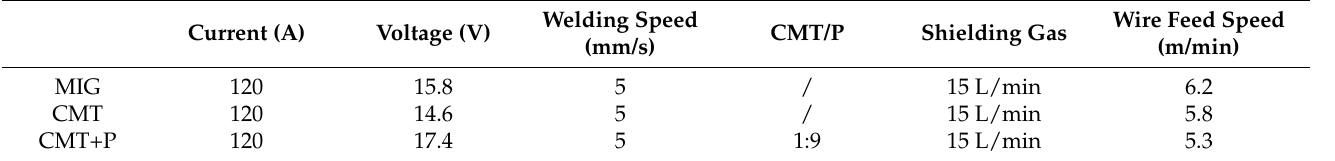
Table 2. Welding parameters.